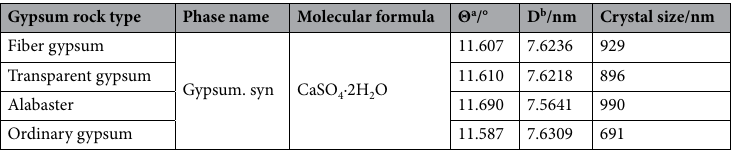
Table 2. Data retrieval results of MDI Jade 6.0 software. a θ is the diffraction angle of the main peak; b D is the crystal surface spacing.